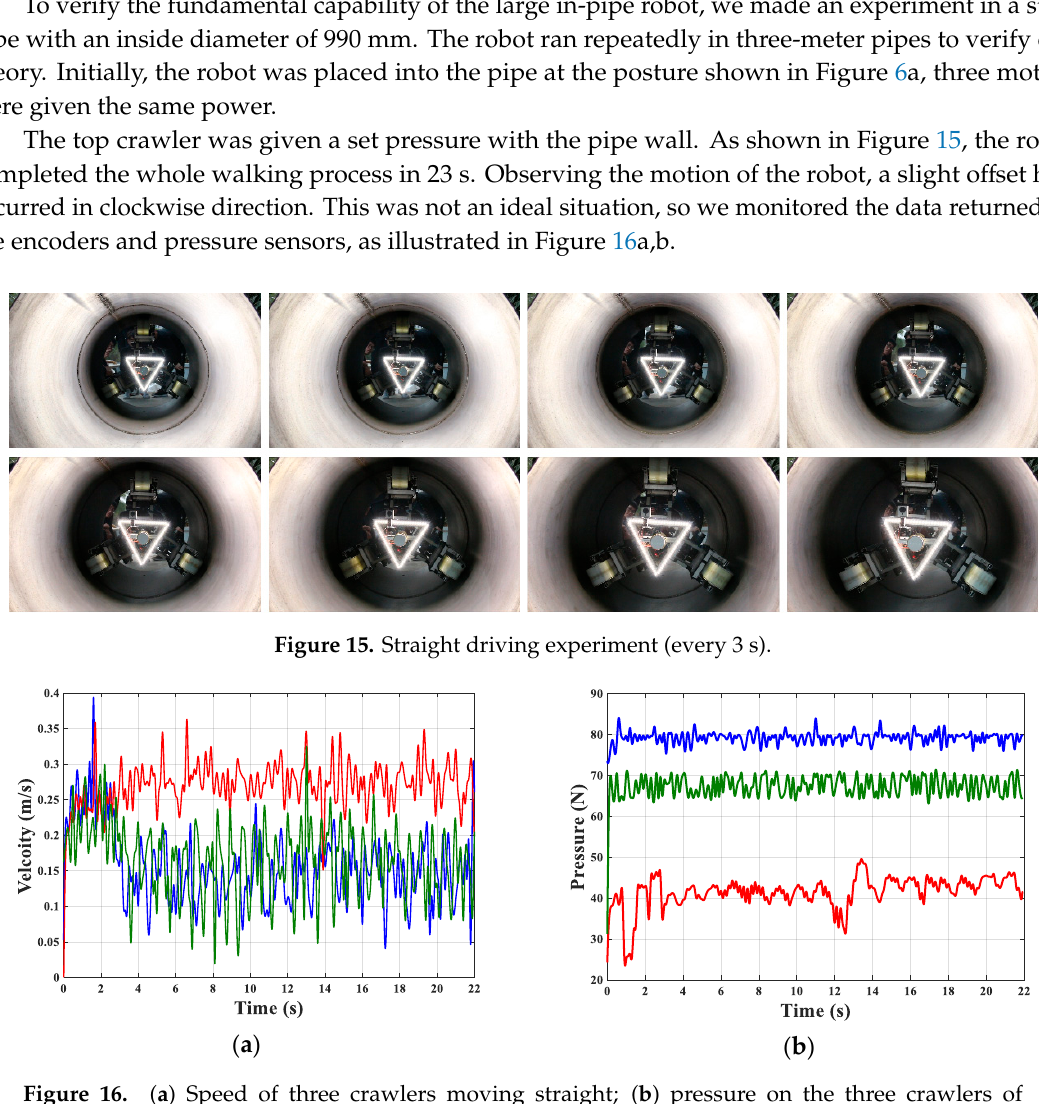
Figure 16. ( a ) Speed of three crawlers moving straight; ( b ) pressure on the three crawlers of moving straight.